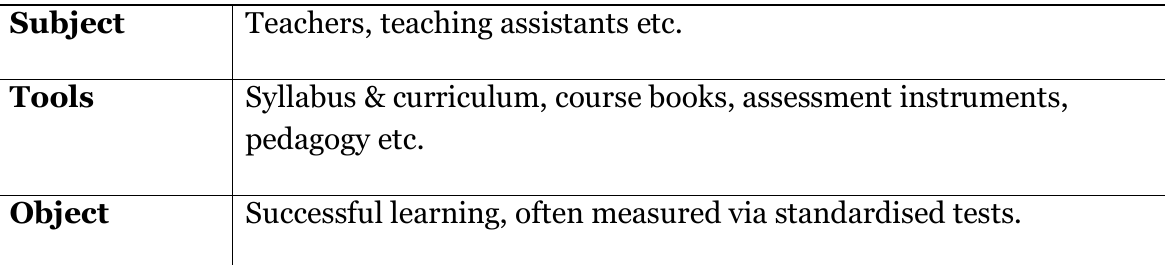
Table 1: elements of a school activity